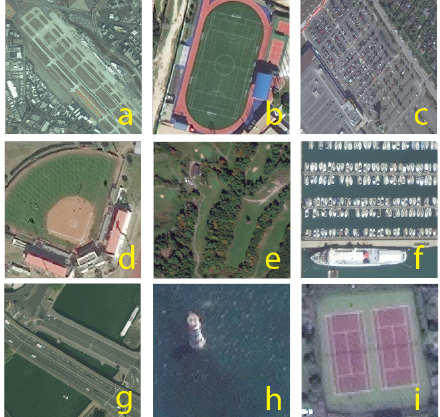
Figure 1: Examples of 9 of the object classes we consider in our data-set, including a : Runway, b : Soccer Field, c : Parking Lot, d : Baseball field, e : Golf course, f : Pier, g : Bridge, h : Lighthouse, and i : Tennis